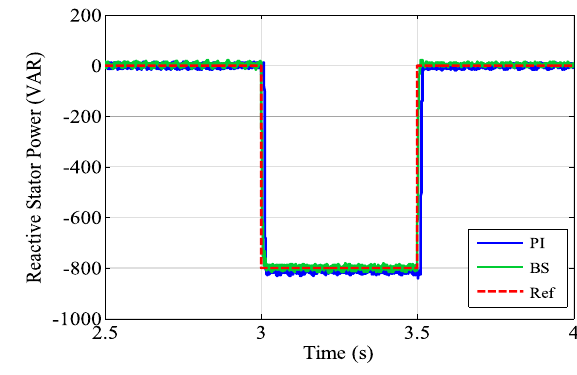
Fig. 19 Reactive Stator Power Qs